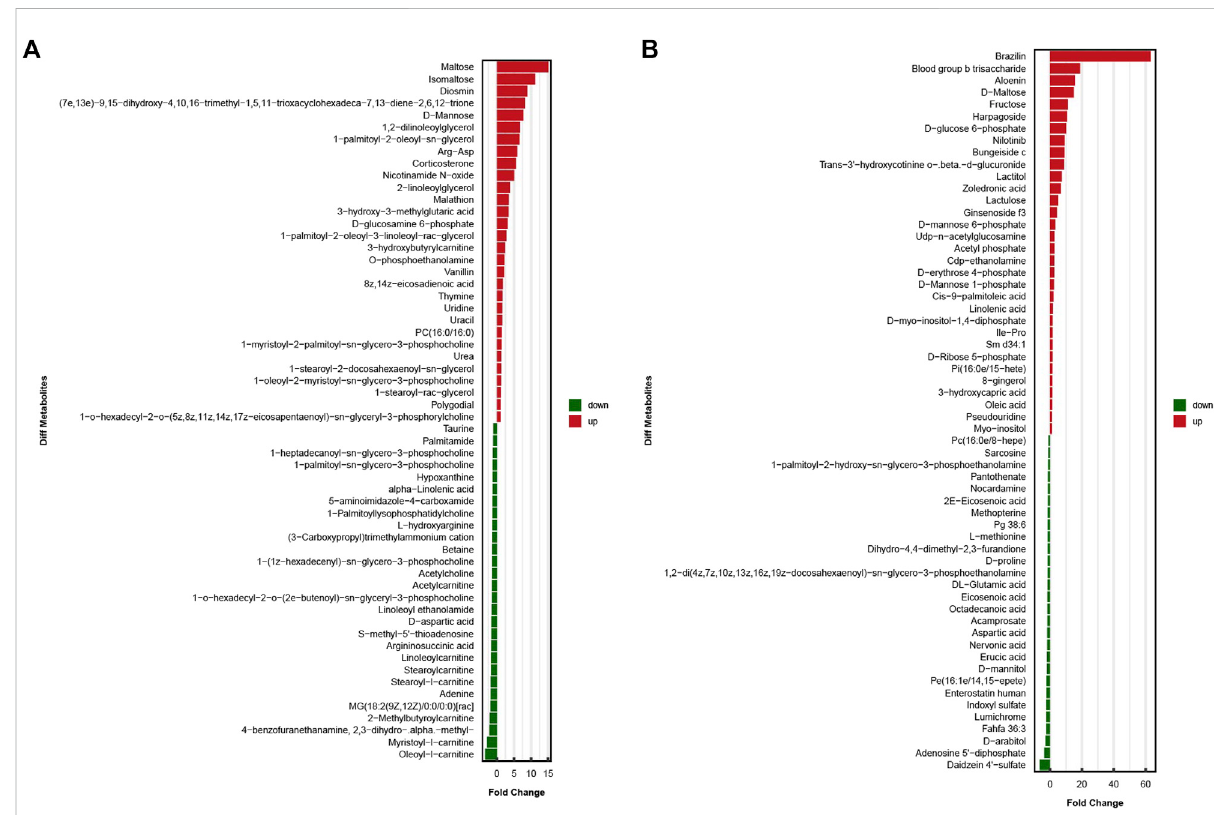
FIGURE 3 In two ionization modes, one-dimensional, and multi-dimensional analysis results of differential metabolites. (A) signi fi cant differences in metabolite expression in positive ionization modes. (B) signi fi cant differences in metabolite expression in negative ionization